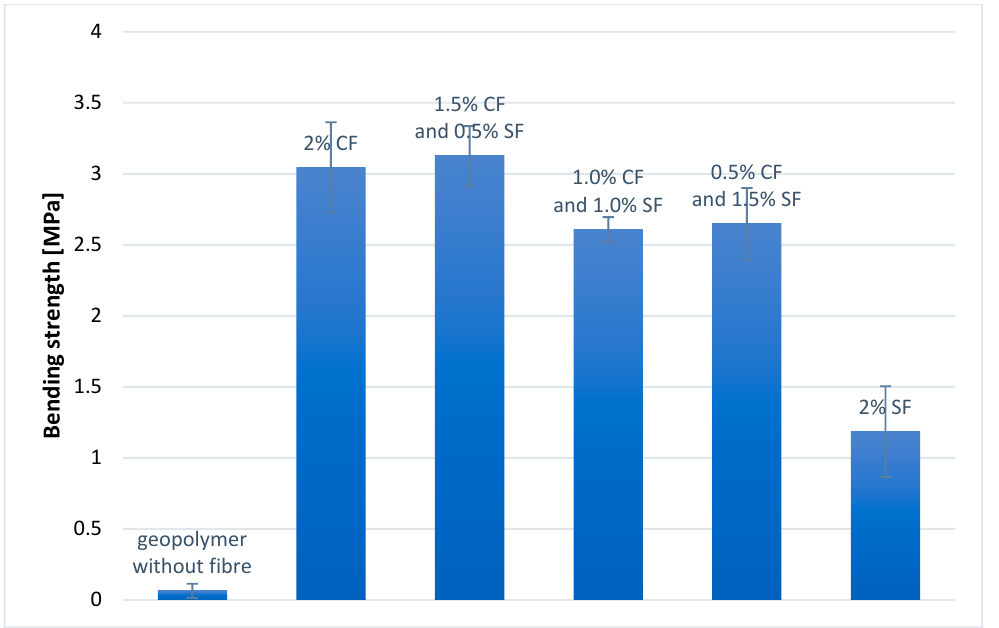
Figure 9. Bending strength of geopolymer composites.